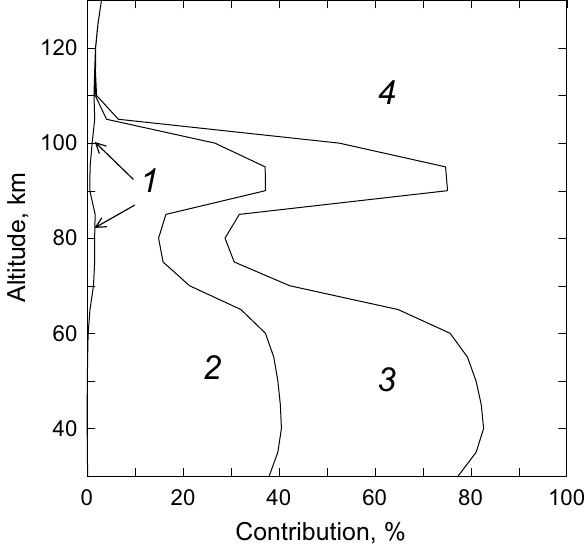
Fig. 6. Altitude profile of the number densities of the molecules in the state O 2 (X 3 6 − g , v=1) calculated selectively for four main non- LTE channels if only one channel has been taken into account for the conditions of experiment METEORS (Mlynczak et al., 2001) in accordance with our model: 1 – ozone photolysis in the Hartley, Huggins and Chappius bands; 2 – photolysis of O 2 in the Shumann- Runge continuum and Lyman- α ; 3 – absorption by O 2 of solar ra- diation at 689 and 762nm bands; 4 – reaction O 3 +O → O 2 (X 3 6 − g , v)+O 2 (see Table 5); 5 – total density (all channels are taken into